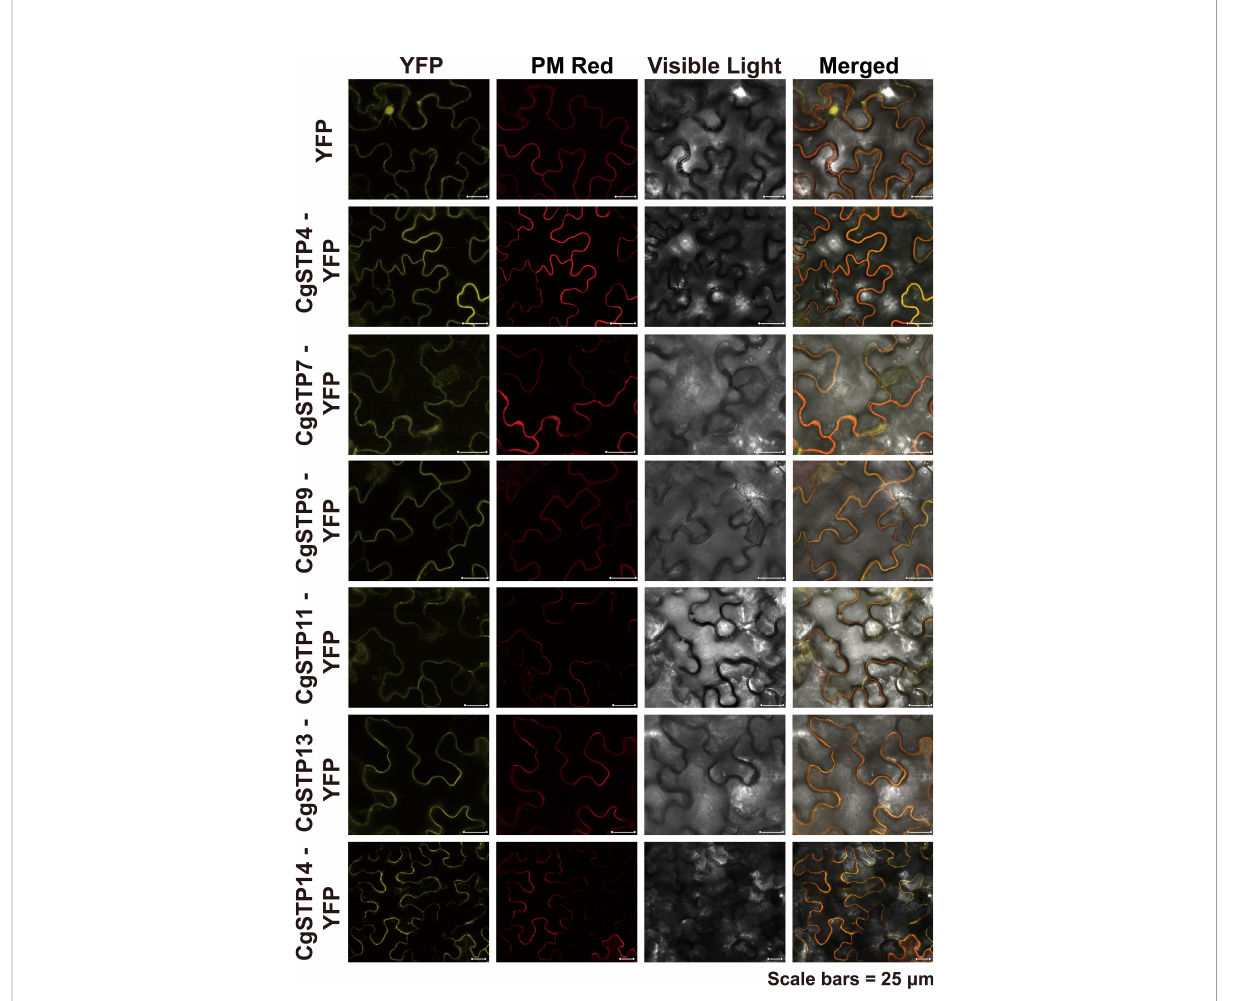
FIGURE 4 Subcellular Localization of CgSTPs. Tobacco leaves expressing 35S:YFP or 35S:CgSTP(s)-YFP, in colocalization with plasma membrane Deep Red marker, were visualized with a confocal laser microscope. Scale bars = 25 m